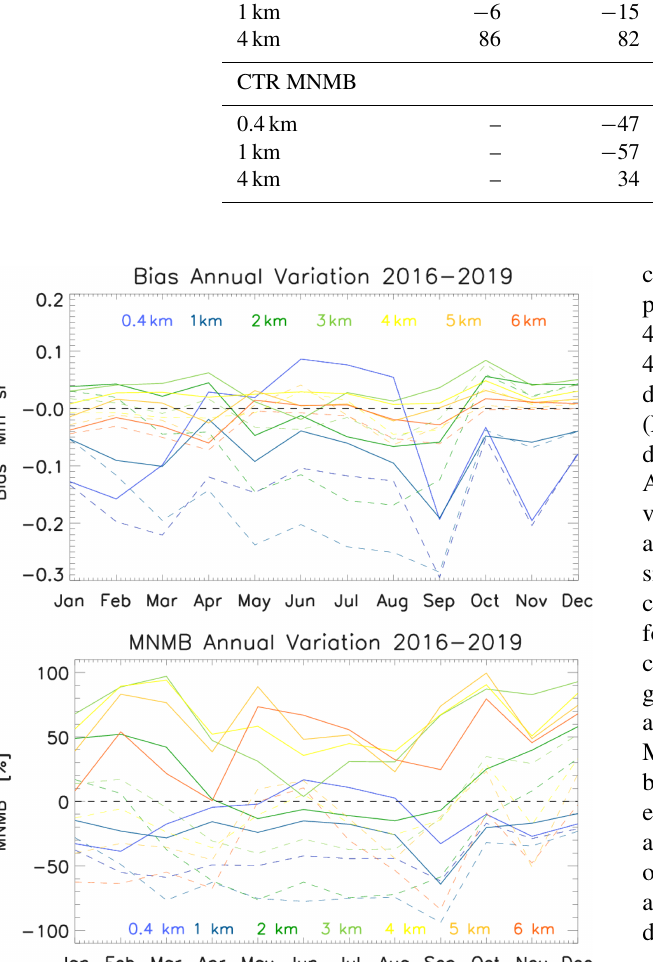
Figure 4. Annual variation of bias and MNMB of β ∗ (z) for ASM and CTR (dashed) combined from 21 German stations in 2016–